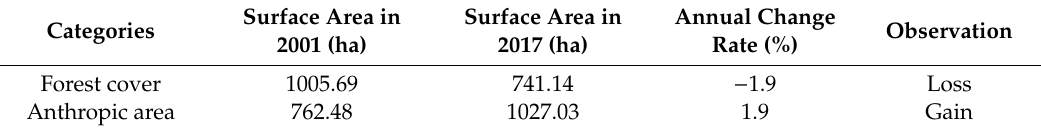
Table 1. Annual Changes in Yawalo’s Forest Cover (2001–2017).